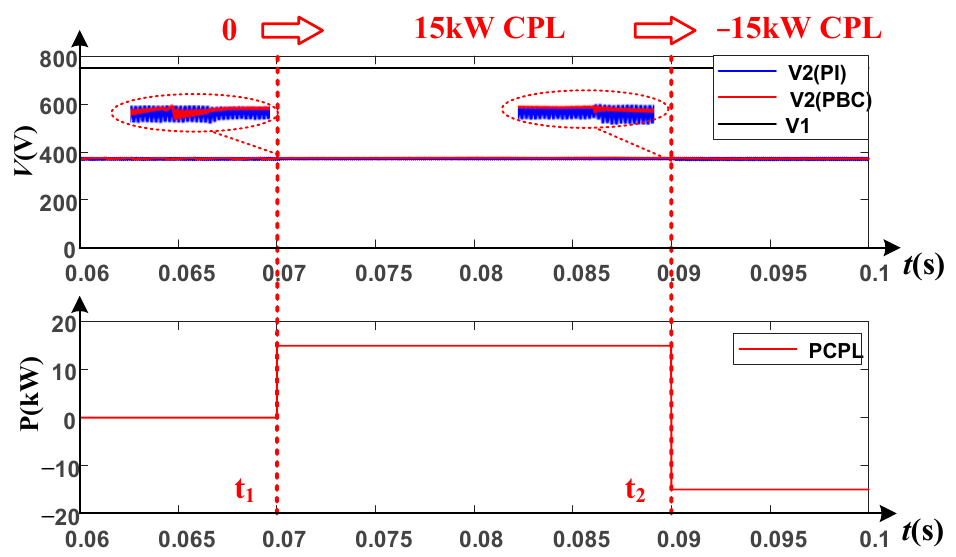
Figure 4. Waveforms in CPL perturbation simulation.